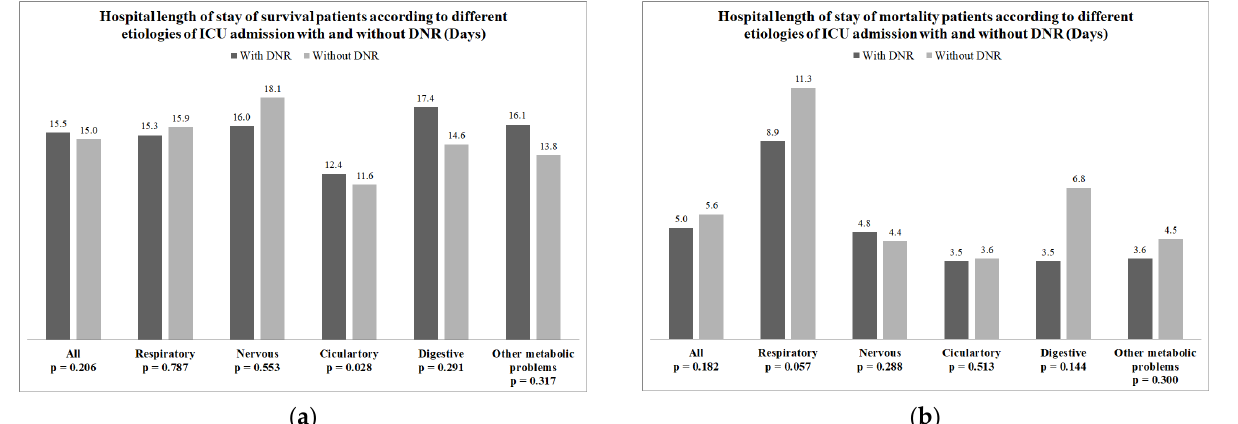
Figure 2. ( a ) The median days of hospital length of stay of all patients who survived and those with different etiology for intensive care unit (ICU) admission after 1:4 propensity score matching; ( b ) the median length of hospital stays of all patients who died and those with different etiology for ICU admission after 1:4 propensity score matching. Table 4. Predicotors of prolonged hospital length of stay in survival patients.